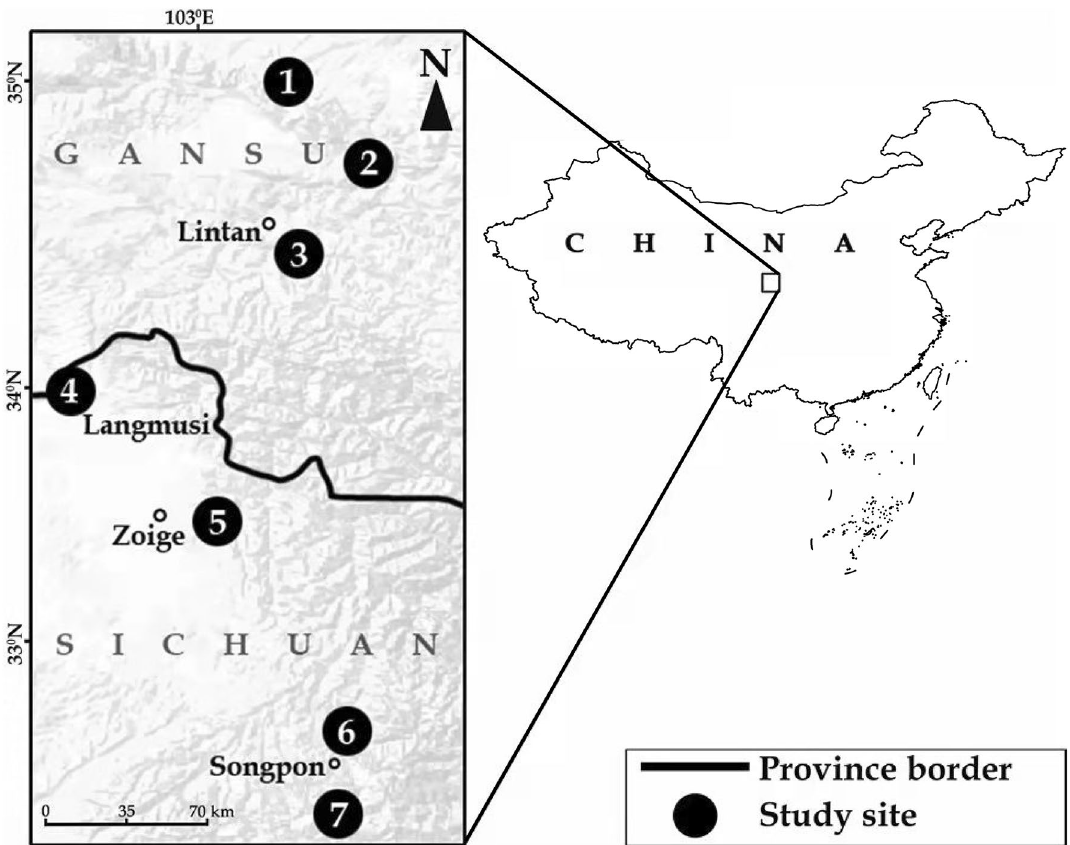
Figure 1. The map of the sampling sites of the karyotyped small mammals in China. (1) Taizishan National Nature Reserve, Hubei County, Gansu Province, 2500 m a.s.l., N35° 14 ′ , E103° 25 ′ ; (2) Lianhuashan National Nature Reserve, Gansu Province, 3100 m a.s.l. N34° 55 ′ , E 103° 44 ′ ; (3) Zhuoni County, Gansu Province, right bank of Tao River, 2600 m a.s.l., N34° 34 ′ , E103° 27 ′ ; (4) Hongxing town (Langmusi), Songpan County, Sichuan Province, 3450 m a.s.l., N34° 04 ′ , E102° 37 ′ ; (5) Banioucun, Zoige County, Sichuan Province, 3400 m a.s.l., N33° 35 ′ , E103° 09 ′ ; (6) Chuanzhusi town, Songpan County, Sichuan Province, 3300 m a.s.l., N32° 45 ′ , E103° 38 ′ ; (7) Xiaobaosi vil., Songpan County, Sichuan Province, 3000 m a.s.l., N32° 29 ′ , E103° 35 ′ . The map was made using QGIS (v.3.16) (QGIS Geographical Information System, https:// qgis. org/ ru/ site/). A map layer was taken from China Standard Map Service (http:// bzdt. ch. mnr. gov. cn/). The figure was created in Adobe Photoshop (v 21.2.0) (https:// www. adobe. com/ ru/ produ cts/ photo shop. html) by V. D. (chromosome 10) and 10 medium-to-small acrocentric pairs (chromosomes 11–20). Two mid-size acrocentrics were identified as X chromosomes. Silver nitrate staining revealed terminal localisation of NORs on short p-arms of a small acrocentric pair only (Fig. 4a, inset). For the Gansu shrew S. cansulus Thomas, 1912, endemic to China, three specimens (G17-72, G18-79 and G18-80) were collected at sites No. 4 and 5. The karyotype is presented for the first time: 2n = 42, NF a = 64 (Fig. 4b). The autosomal set is composed of 20 bi-armed and eight single-armed autosomes. Among them, there are five large metacentric pairs (chromosomes 1–5) and one small metacentric pair (chromosome 6), four large (chromosomes 7–10) and two small (chromosomes 11 and 12) submetacentric pairs and eight medium-to- smallest subtelocentric pairs (chromosomes 13–20). Two large acrocentrics and a dot-like acrocentric are XX and Y chromosomes, respectively (Fig. 4b, inset). Silver nitrate staining revealed terminal localisation of NORs on short p-arms of two small bi-armed pairs (Fig. 4b, inset). As for De Winton’s shrew Ch. hypsibia (de Winton, 1899), endemic to China, one male (G18-290) was col- lected at site No. 3. The karyotype is presented for the first time: 2n = 65, NF a = 66. The autosomal set consists of 30 large-to-small acrocentric pairs (chromosomes 1–30) gradually decreasing in size, one small metacentric pair (chromosome 31) and an unpaired small metacentric chromosome, which apparently is a B chromosome (Fig. 5a). C-heterochromatic blocks were revealed in pericentromeric regions of 27 acrocentric pairs (chromosomes 3–29). Two large acrocentric pairs (chromosomes 1 and 2) and one smallest acrocentric pair (chromosome 30) as well as the small metacentric pair are C-negative. Slightly visible blocks of interstitial heterochromatin were noted on the B chromosome. Because one acrocentric chromosome has a large pericentromeric C-block, we identified it as an X chromosome (Fig. 5b). The Y chromosome was tentatively identified as an acrocentric